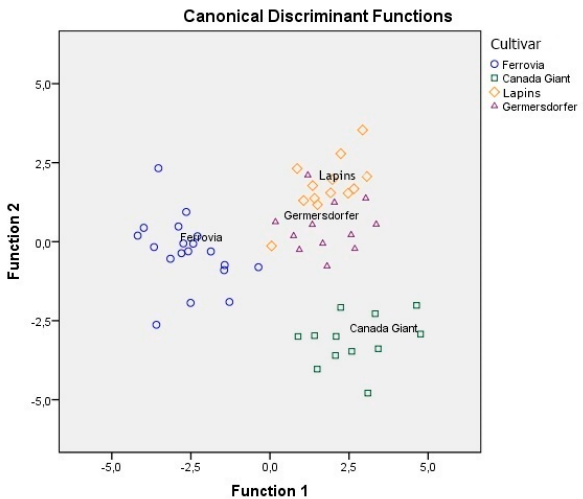
Figure 2. Differentiation of four cultivars based on the combination of minerals and conventional quality parameters.